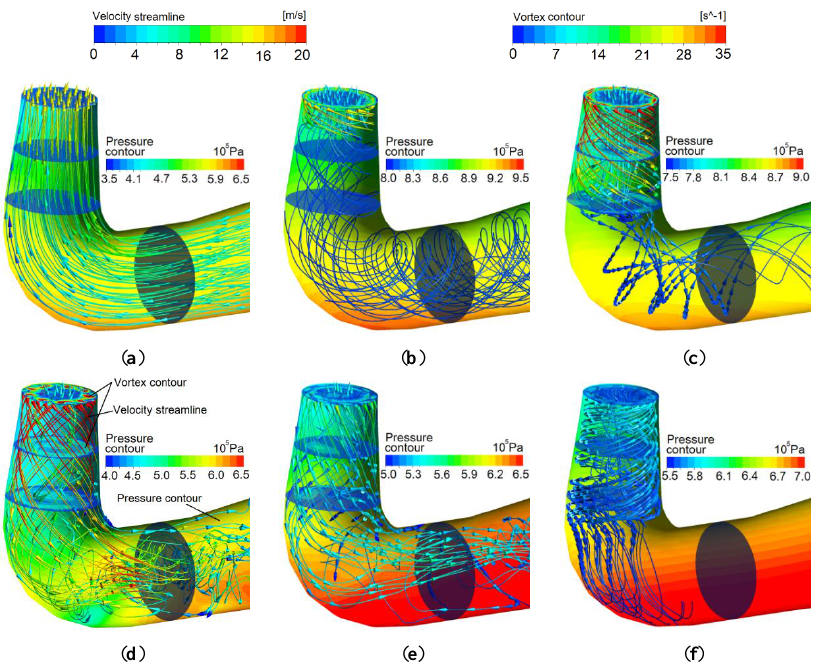
Figure 12. Flow fields in draft tube at different moments. ( a ) t = 0 s; ( b ) t = 6 s; ( c ) t = 7 s; ( d ) t = 12 s; ( e ) t = 20 s; ( f ) t = 33 s. ( e ) t = 20 s; ( f ) t = 33